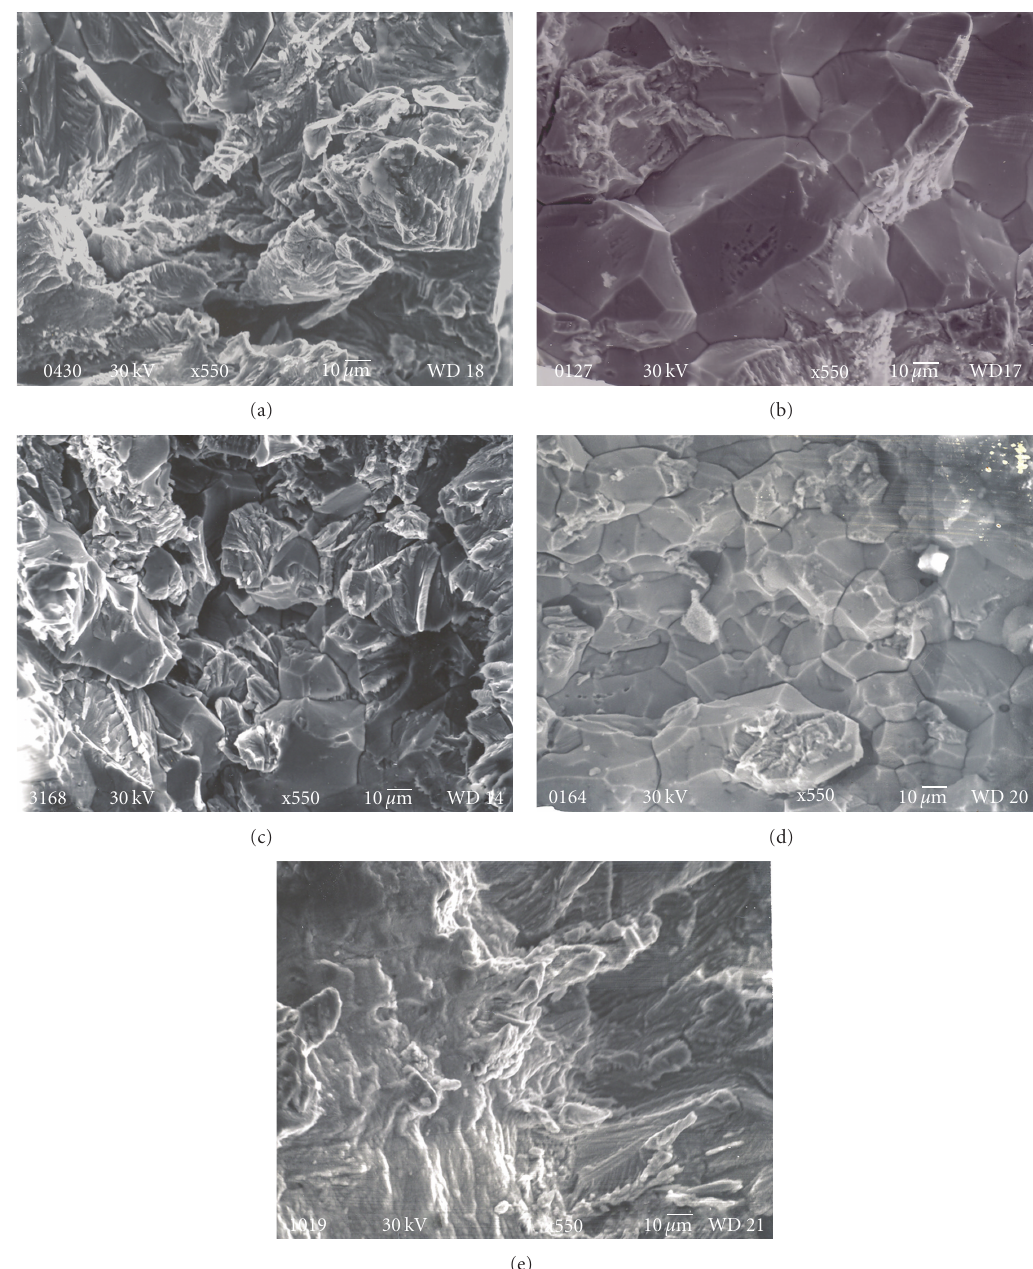
Figure 3: (a) Transgranular cracking for type 304 at T = 527 K, (b) intergranular cracking for type 304 austenitic stainless steel at T = 403 K (x550), (c) transgranular cracking for type 316 austenitic stainless steel at T = 527K, (d) intergranular cracking for type 316 austenitic stainless steel at T = 414 K (x550), and (e) transgranular cracking for type 310 austenitic stainless steel at T = 414 K in boiling saturated MgCl 2